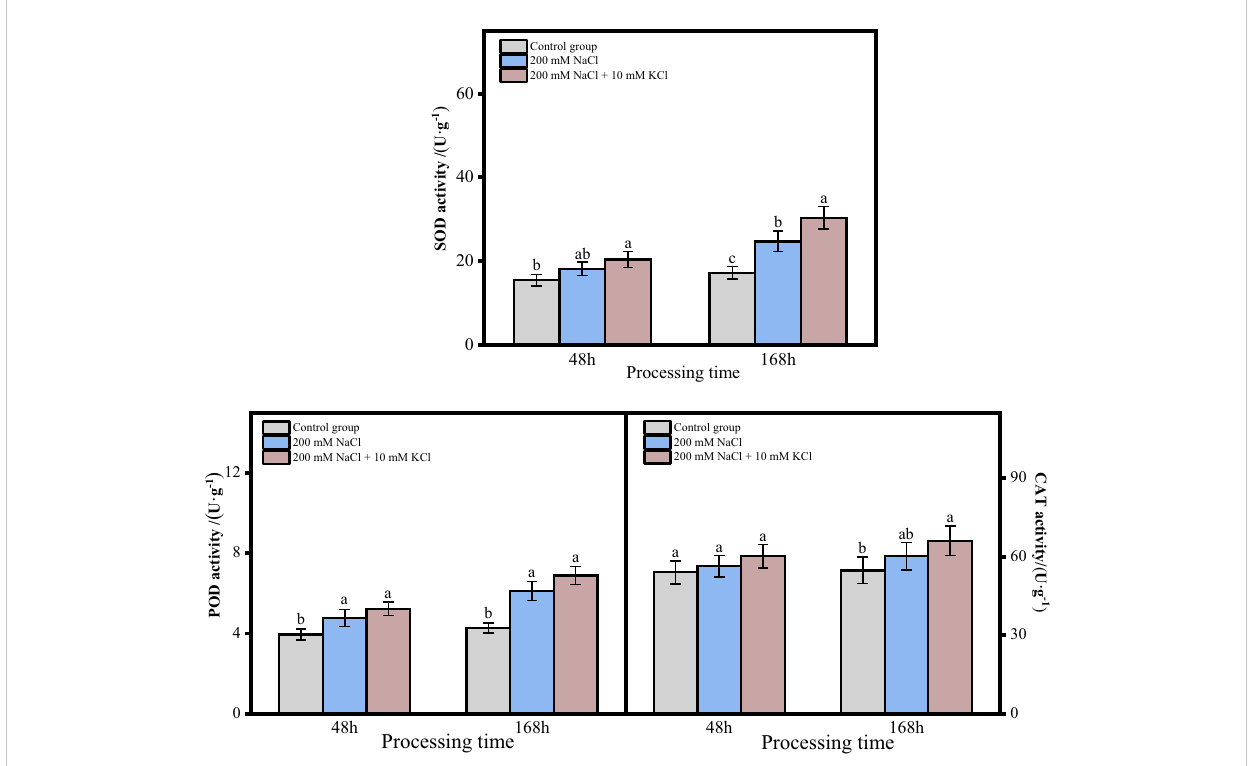
FIGURE 2 Change of antioxidative enzyme activity of T. ramosissima roots under NaCl stress with exogenous K + application. (Changes of SOD, POD and CAT activities in the roots of T. ramosissima at 48h and 168h in the control group and different treatment groups. Different letters indicate the signi fi cance of differences among treatments at the same time, p <